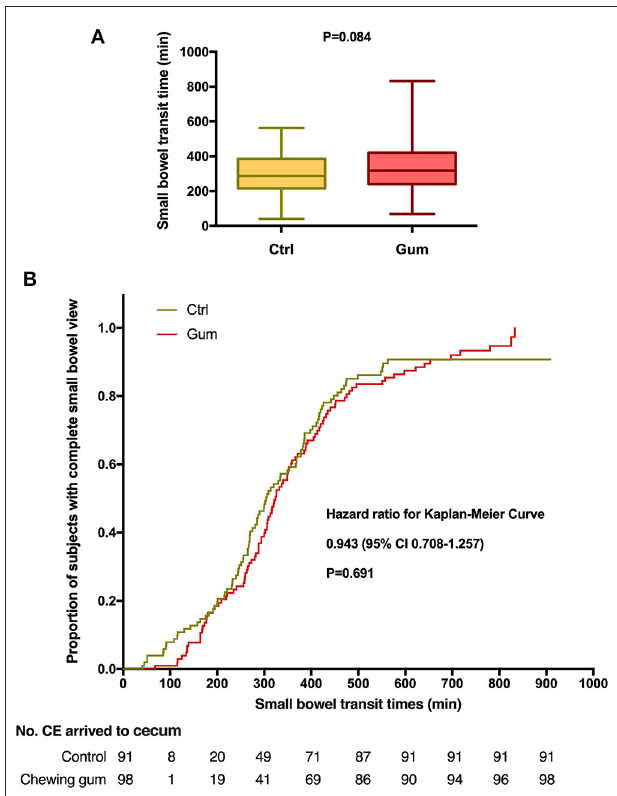
FIGURE 3 | Small bowel transit time during capsule endoscopy in the chewing gum group and control group. (A) A boxplot with medians and quartiles; (B) Kaplan–Meier curves for time to complete small bowel view.